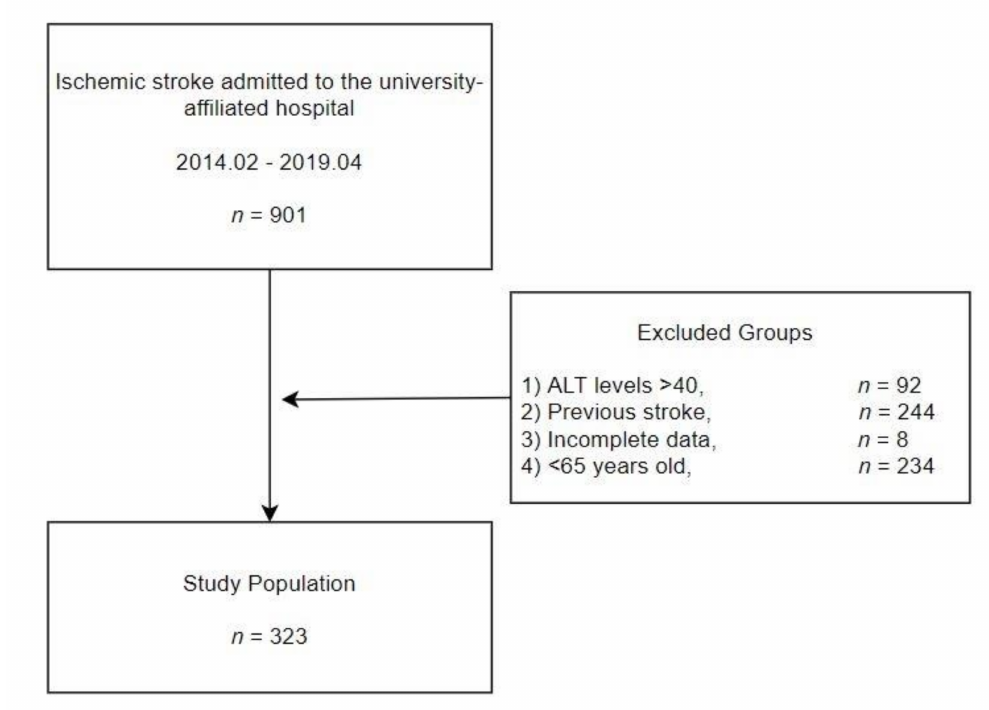
Figure 1. Study population. Of the 901 patients, 92 patients with ALT levels over 40 were excluded and 244 patients had a previous history of stroke. Of the remaining stroke patients, 8 patients had insufficient medical records, and 234 patients under the age of 65 were excluded. Finally, 323 subjects were enrolled in the